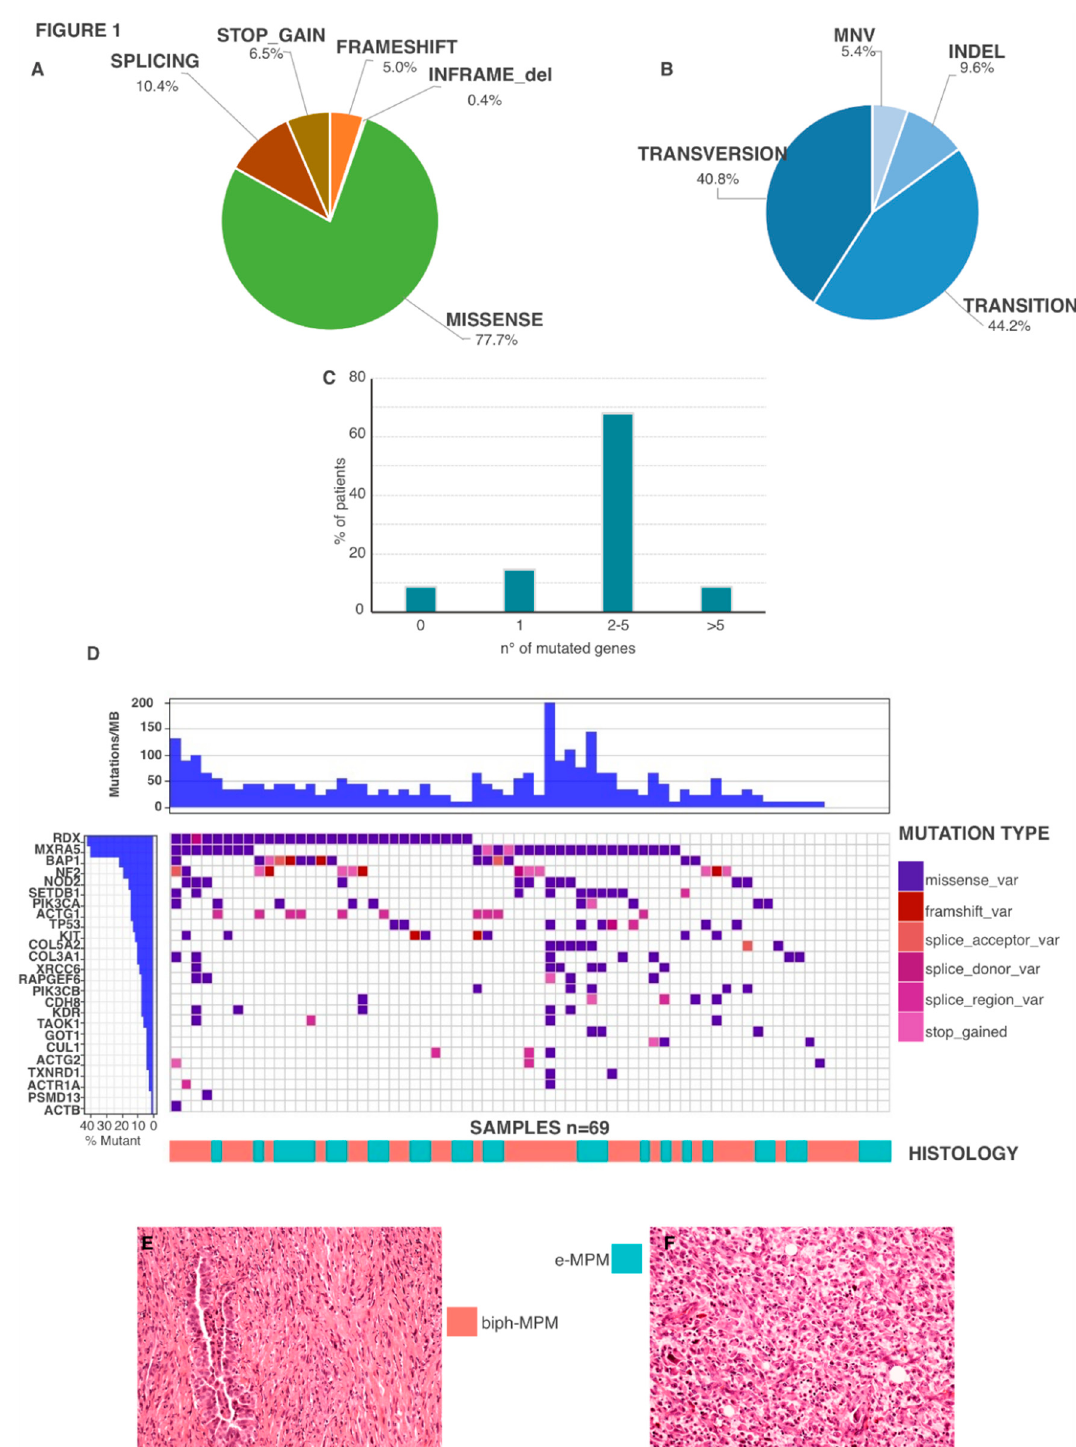
Figure 1. Mutational Profile of the 69 MPMs in analysis. ( A ) Distribution of the somatic mutation events detected in MPMs according with nucleotide substitution. ( B ) Distribution of somatic mutation events detected in MPMs according with predicted functional effects . ( C ) Frequency distribution of the number of mutated genes per patient. ( D ) Waterfall plot representing the gene mutations occurred in each patient (columns). Squares of different colors indicate different mutation types. Upper histograms represent the estimated number of mutations per Megabase for each patient ( E , F ). Colored lines in the bottom discriminates patients with different histotypes.